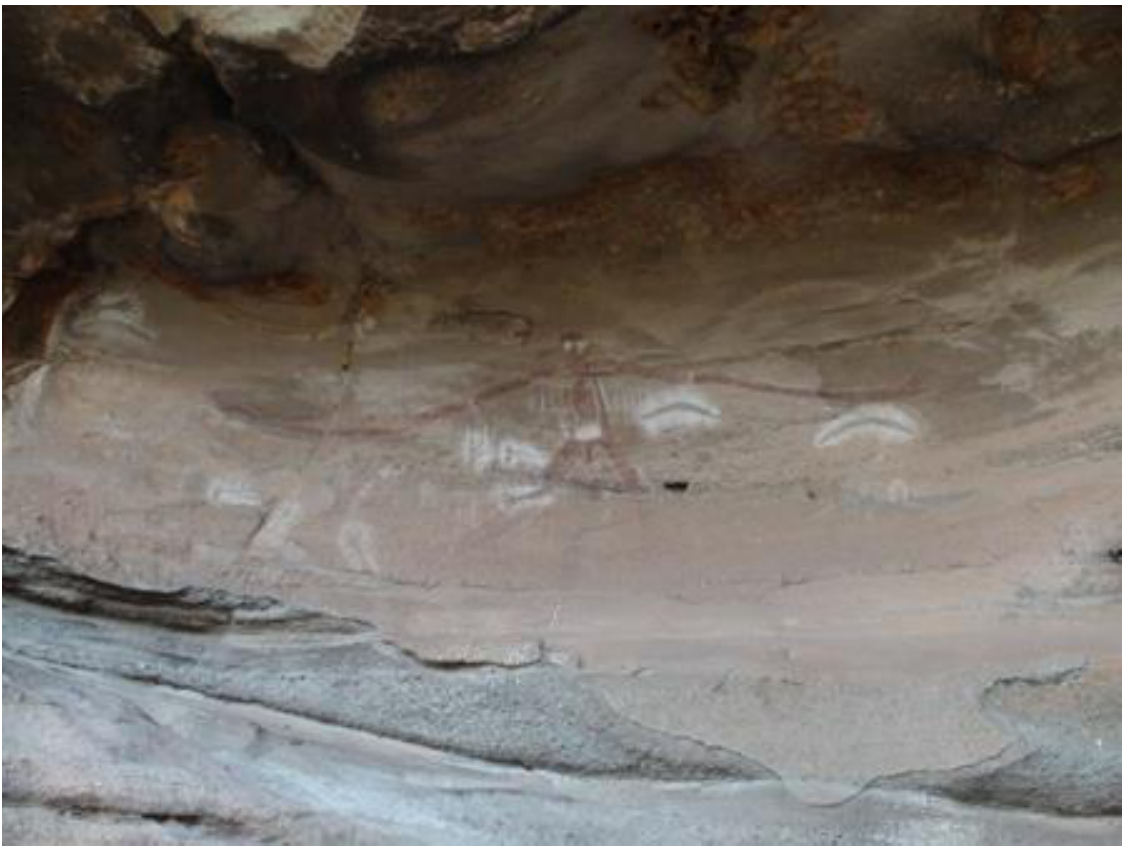
Figure 14. Milbrodale Baiame with associated stencils including hands, central Hunter Valley, New South Wales,